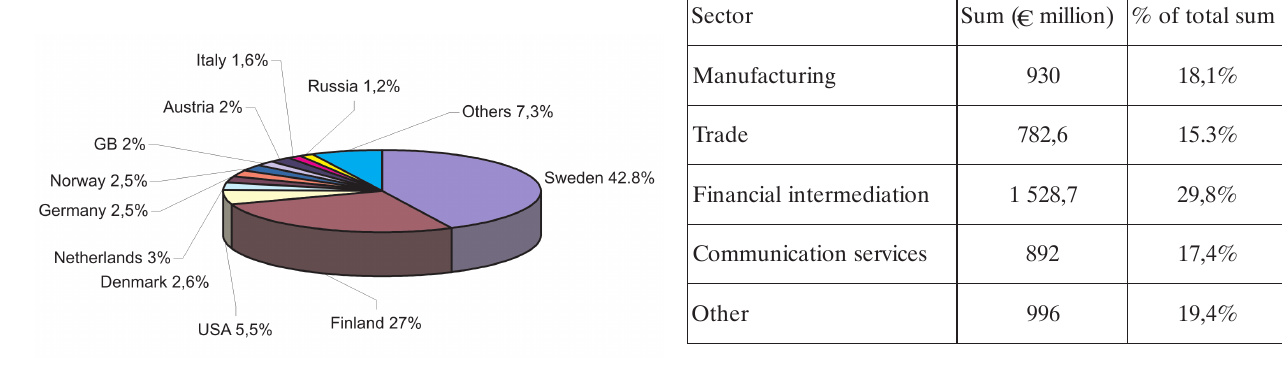
Figure 4 . FDI in Estonia by countries, 2004 (Bank of Estonia)